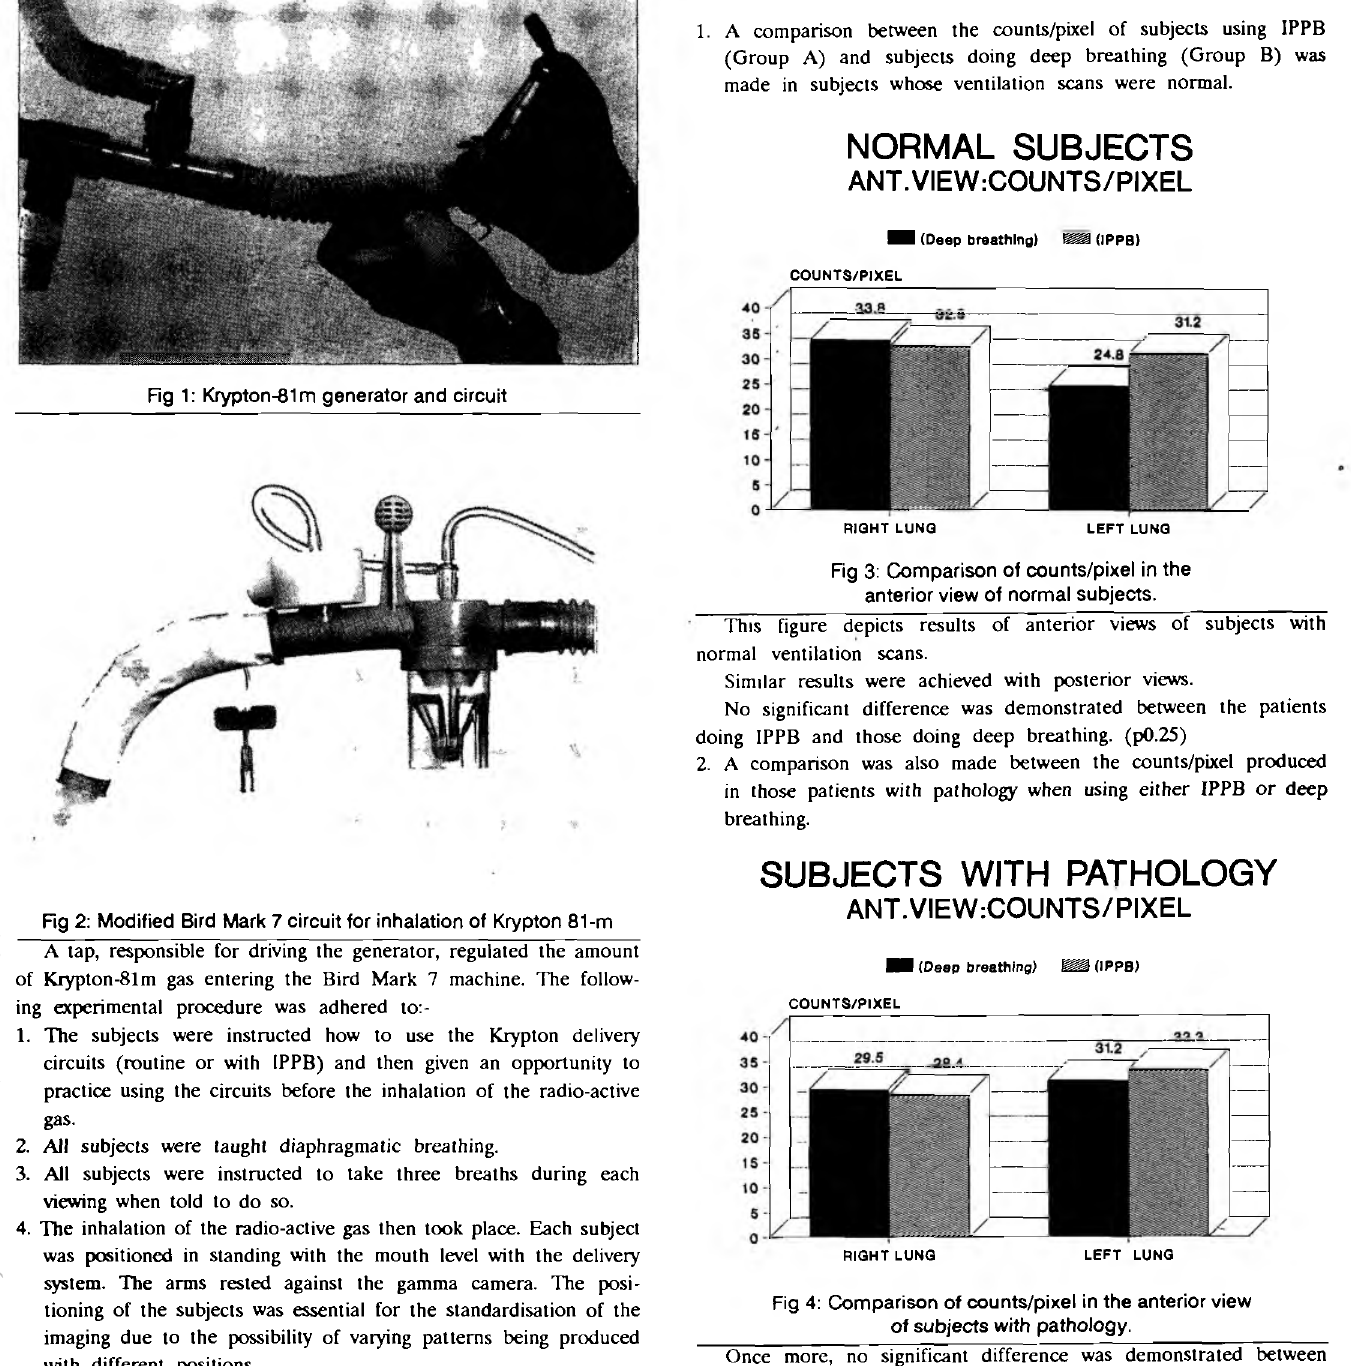
Fig 4: Comparison of counts/pixel in the anterior view of subjects with